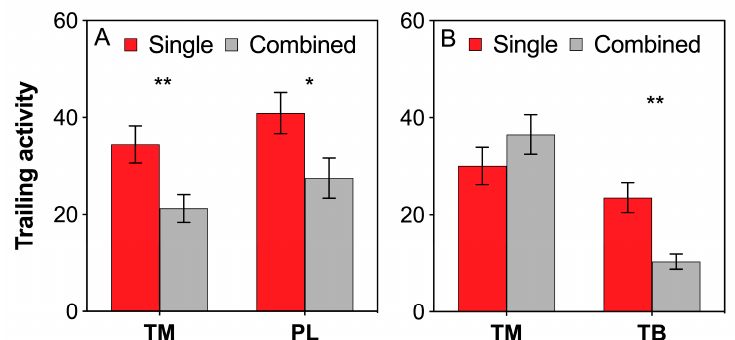
Figure 2. Effects of interference competition on ant trailing activity. ( A ) T. melanocephalum - P. longicornis interaction; ( B ) T. melanocephalum - T. bicarinatum interaction. The data are presented as the mean ± SE. Asterisk (* or **) on bars indicates significant differences between the treatments ( P < 0.05 or P < 0.01). Tapinoma melanocephalum , Paratrechina longicornis and Tetramorium bicarinatum were abbreviated into TM, PL and TB,